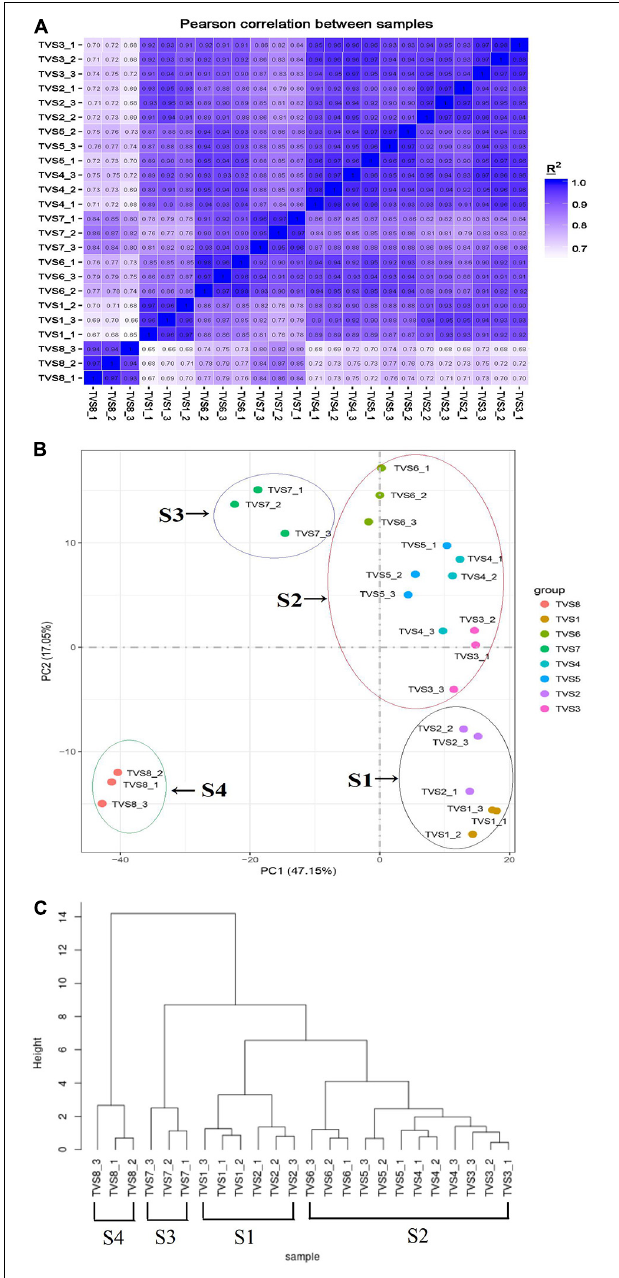
FIGURE 2 | Correlation between the transcriptomes of different samples during CF of T . virens GV29-8. (A) Pearson correlation coefficient analysis of RNA-seq data from 8 sampling time points of T . virens GV29-8. (B) Principal component analysis (PCA) plot showing clustering of transcriptomes of different T . virens GV29-8 samples. The samples in black, red, purple and green circles represent S1, S2, S3, and S4 samples, respectively. (C) Phylogenetic analysis of sample correlation